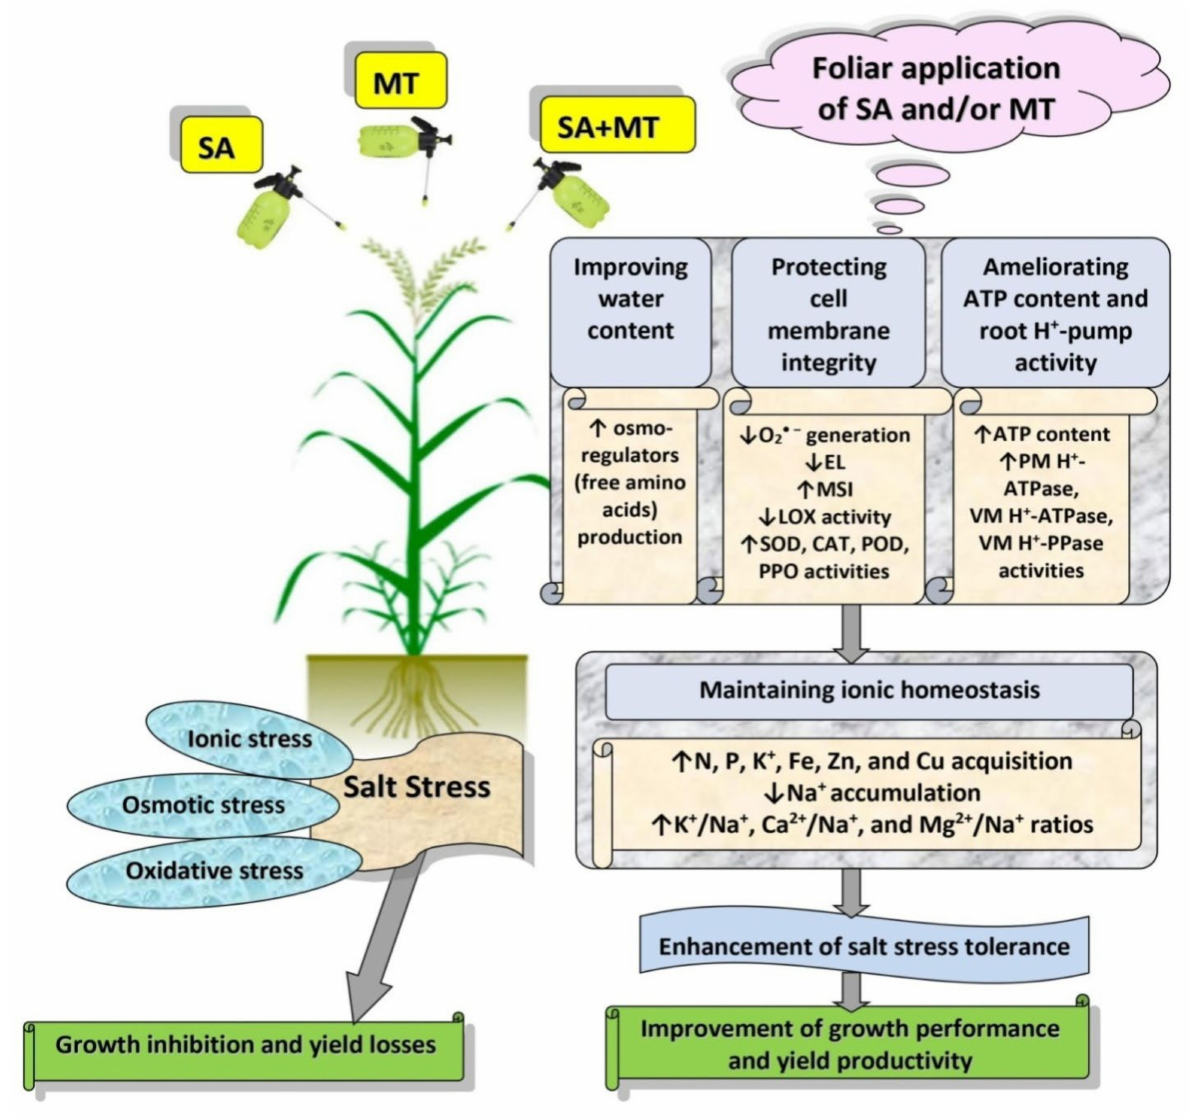
Figure 7. Foliar applications of SA and MT alleviate salt stress impacts on wheat growth and produc- tivity by improving the ATP content, root H + -pump activity, water content, and ROS detoxification, which in turn maintain the ionic